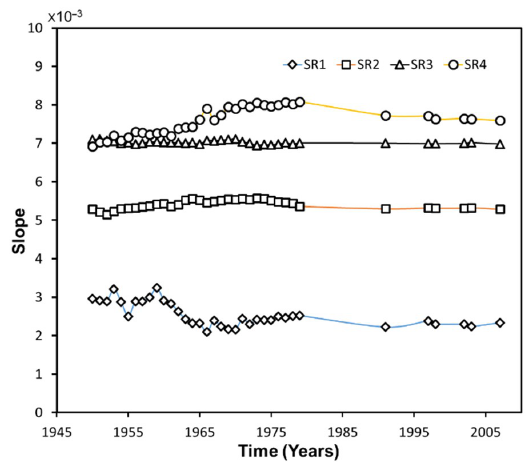
Figure 9. Spatial and temporal variations in slopes.